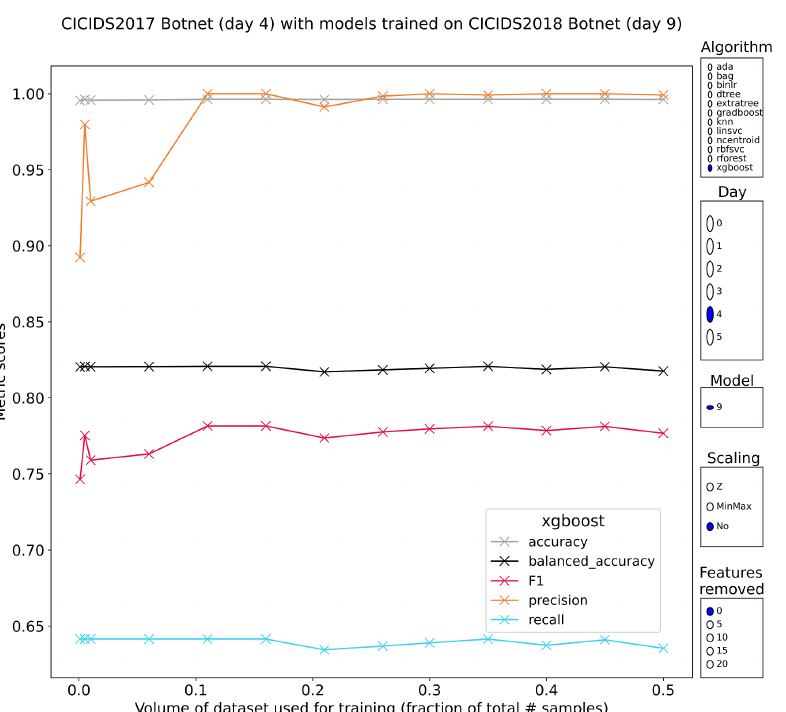
Figure 8. Best-case generalized performance by gradient-boosted, regularized decision tree ensembles on the botnet